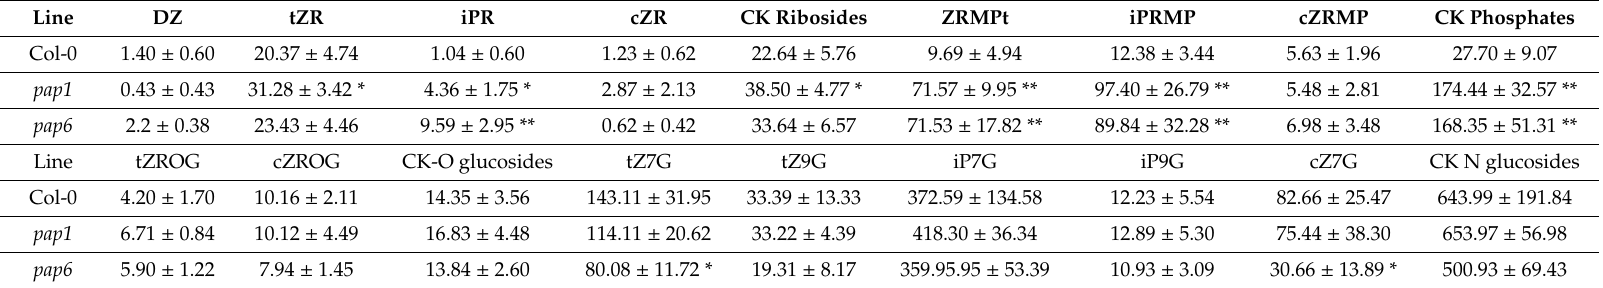
Table 1. The impact of pap mutations on CK content (pmol / g fresh weight) of Arabidopsis thaliana 5-week-old rosette